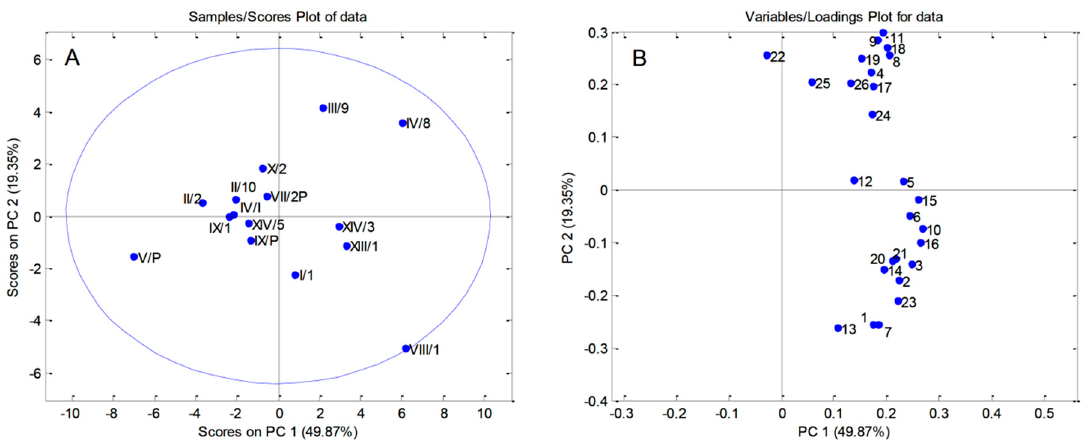
Figure 1. Principal component (PC) scores and loadings plot on quantified polyphenols ( A , B ) from pollen samples of 15 ‘Obla č inska’ sour cherry clones. Numbers on ( B ) correspond to the quantified polyphenols as given in Table 4.